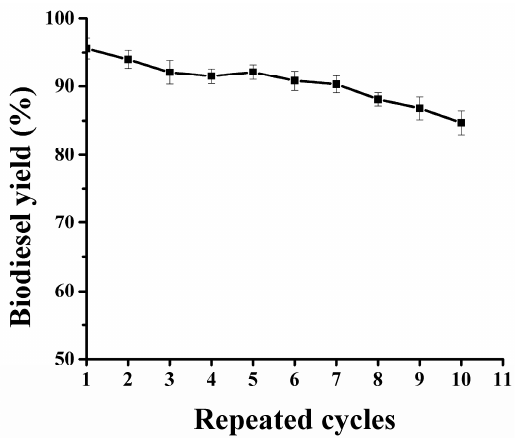
Figure 8. Reuse of RML@ZIF ‐ 8 for biodiesel production.